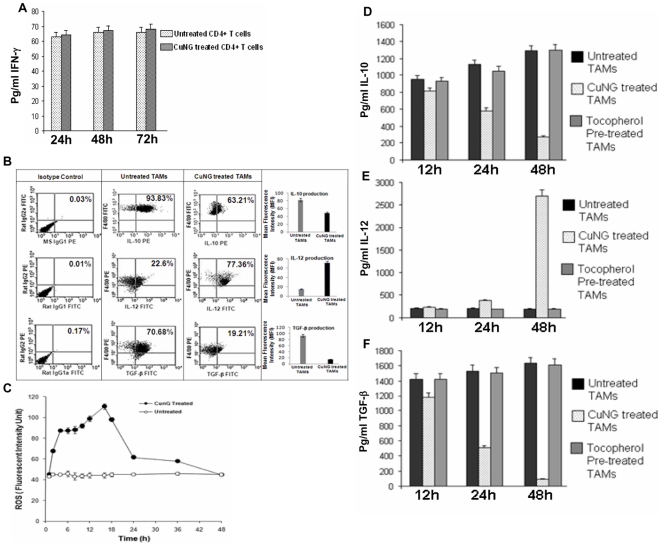
Both in vitro and in vivo CuNG treatment caused alteration of cytokines profile of TAMs.A) ELISA. B) Flow cytometry. C) Fluorometric analysis. D, E & F) ELISA. In vitro CuNG treatment (2.5 µg/ml) did not change IFN-γ production from CD4+ T cells of TALs of untreated EAC/Dox bearing mice (A). TAMs were purified from peritoneal ascitic fluid of both untreated and 15 days of CuNG treated EAC/Dox bearing mice and labeled with anti F4/80 antibodies and with either intracellular IL-10 or IL-12 or TGF-β or with specific isotype control Abs. Immunofluorescence analysis were performed by flow cytometry. Representative data of 3 independent experiments is presented (B). Purified TAMs were either kept untreated or treated with CuNG in vitro and ROS was measured [in terms of peroxide using dichlorofluorescein diacetate (DCF-DA)] at different time points. Results are presented as mean±SD of 3 independent experiments (C). Purified TAMs from untreated EAC/Dox bearing mice were plated (2×106 cells/500 µl). Cells were either kept untreated or pretreated with tocopherol (50 µM) for 1 h. Then the cells were further cultured for 12 h, 24 h and 48 h in the presence or absence of CuNG (2.5 µg/ml). The culture supernatants were collected and analyzed for cytokines IL-10 (D), IL-12 (E) and TGF-β (F) by ELISA and results are presented as mean±SE of 3 independent experiments, each experiment having every measurement in triplicate.